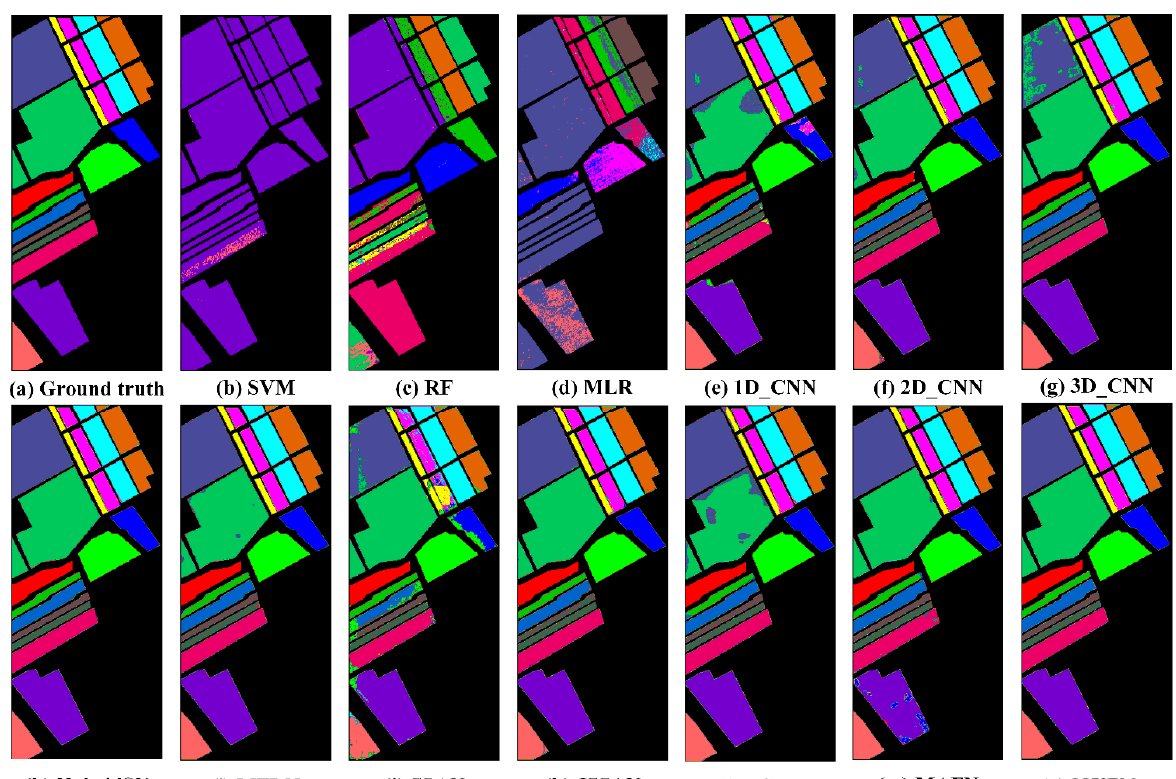
Figure 13. The visual comparisons of the state-of-the-art models and our network on SA dataset.